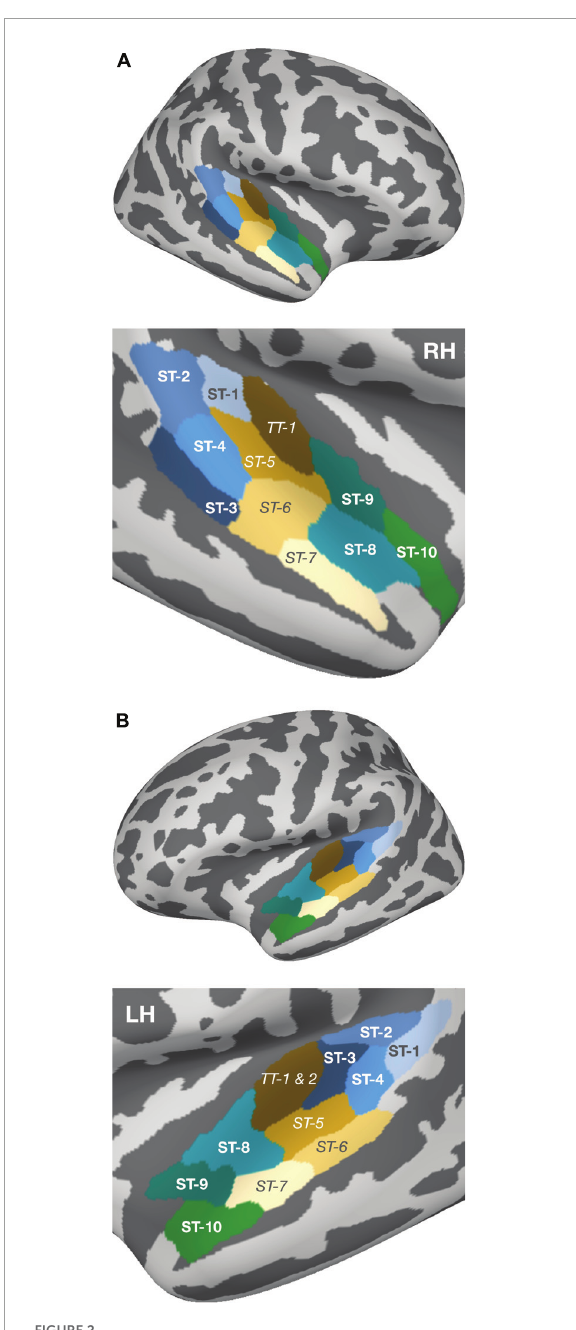
FIGURE2 Parcellation of the auditory cortex according to the aparc_sub atlas (Khan et al., 2018), provided by the MNE software, and projected onto the fsaverage reconstruction. Within panels (A) (right hemisphere) and (B) (left hemisphere), the upper plots depict the whole brain view and the lower plots present an enlarged view of the temporal lobe. Green- and blue-shaded areas indicate the ROIs [i.e., the cortical subregions in PT (blue) and PP (green)] that formed the basis for subsequent source wave extraction. The areas between both ROIs are shown in beige/brown, with their labels in italics; these areas were not used for statistical testing and are illustrated merely to graphically emphasize the spatial separation of the two ROIs that were in the focus of the current